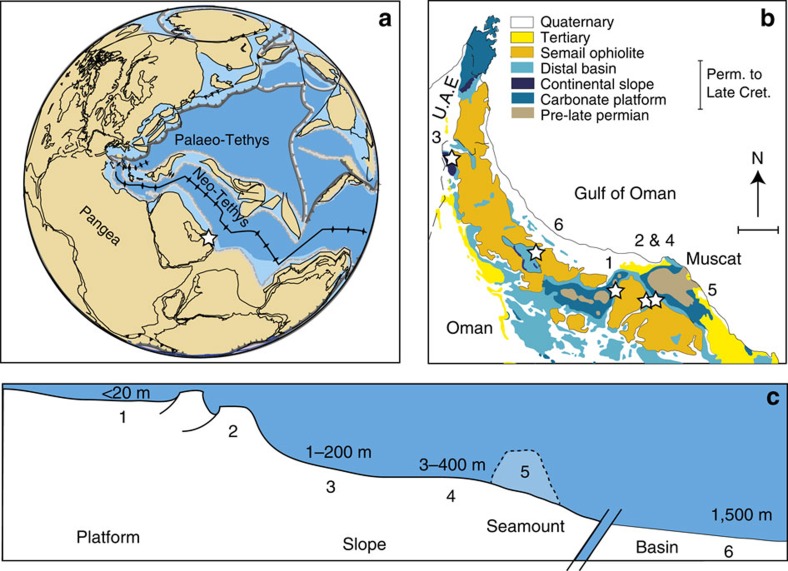
Geological information.(a) Late Permian palaeogeographic reconstruction5370 with the location of the Arabian Margin marked. (b) Simplified geological map of Oman and UAE70 showing site localities; scale bar, 50 km; (1) Saiq Plateau; platform, (2) Wasit Block; distal platform; (3) Sumeini; middle slope, (4) Wadi Wasit South and Radio Tower; distal slope, (5) Ba'id; seamount, (6) Buday'ah; deep basin. (c) Schematic basin cross-section for the Dienerian (not to scale) showing estimated palaeo-depths (based on facies) and site numbers as in b. See Supplementary Note 1 for detailed site descriptions.